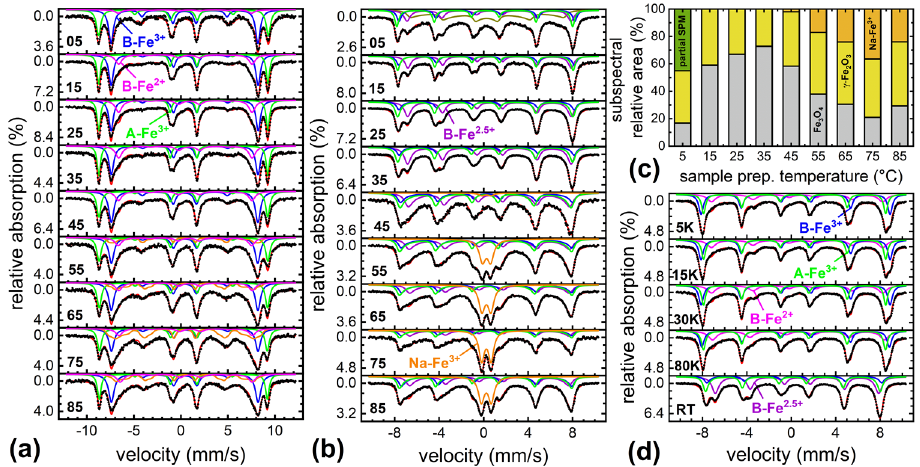
Figure 6. Mössbauer spectra of ( a ) samples S05 to S85 recorded at 4.3 K in an external magnetic field of 5 T parallel to the γ -ray propagation direction and ( b ) at room temperature. Relative subspectral areas representing sample composition as extracted from ( a , b ) are shown in ( c ). Mössbauer spectra of S35 recorded at 5–293 K are shown in ( d ) to demonstrate the magnetite Verwey transition. Subspectra include B-site Fe 3+ (blue), A-site Fe 3+ (green), B-site Fe 2+ (violet), B-site Fe 2.5+ mixed valence states (purple), and a hyperfine field distribution/doublet assigned to the parasitic Na-bearing Fe 3+ -phase (orange). At room temperature, for S05, a broad hyperfine field distribution (olive, ( b )) is observed, presumably originating from beginning superparamagnetic relaxation (SPM)